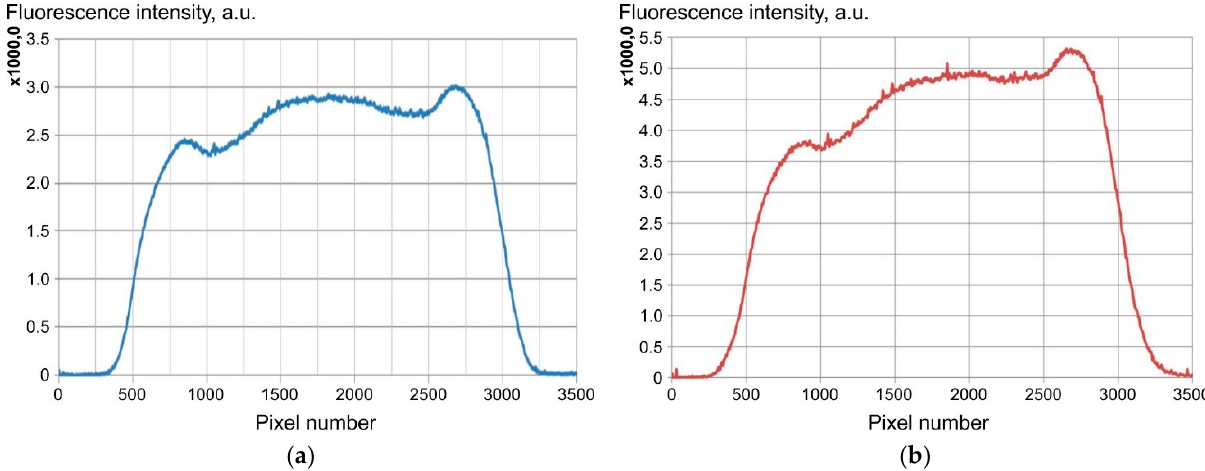
Figure 7. Fluorescence intensity distribution along the milk pipeline at the milk flow velocity: ( a ) 0.01 m/s (with bubbles); ( b ) 0.05 m/s (without visible bubbles).